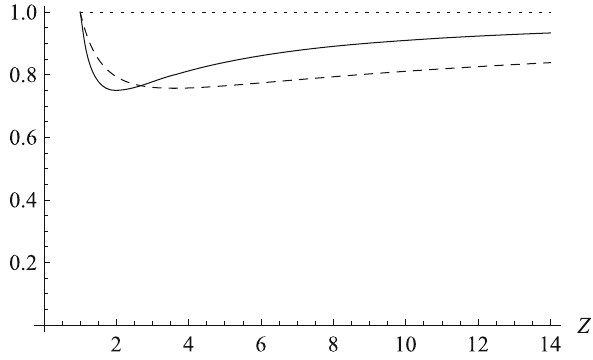
Fig. 6 Z -dependence of modulating factors determining deviation of q at from its pure coherent contribution, for large and for small Coulomb parameters. Solid curve, factor Z − 1 Z + 1 entering Eq. (80) for a semiclas- sical scattering case. Dashed, factor 1 − Z − 1 + Z − 2 entering Eq. (79) for the weakly nonperturbative scattering case. The relative departure of both factors from unity is (cid:2)